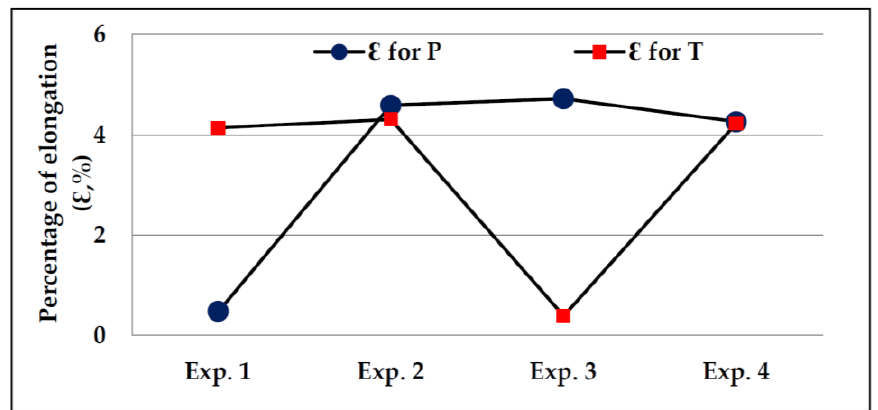
Figure 7. The comparative ε results for both tool pins.